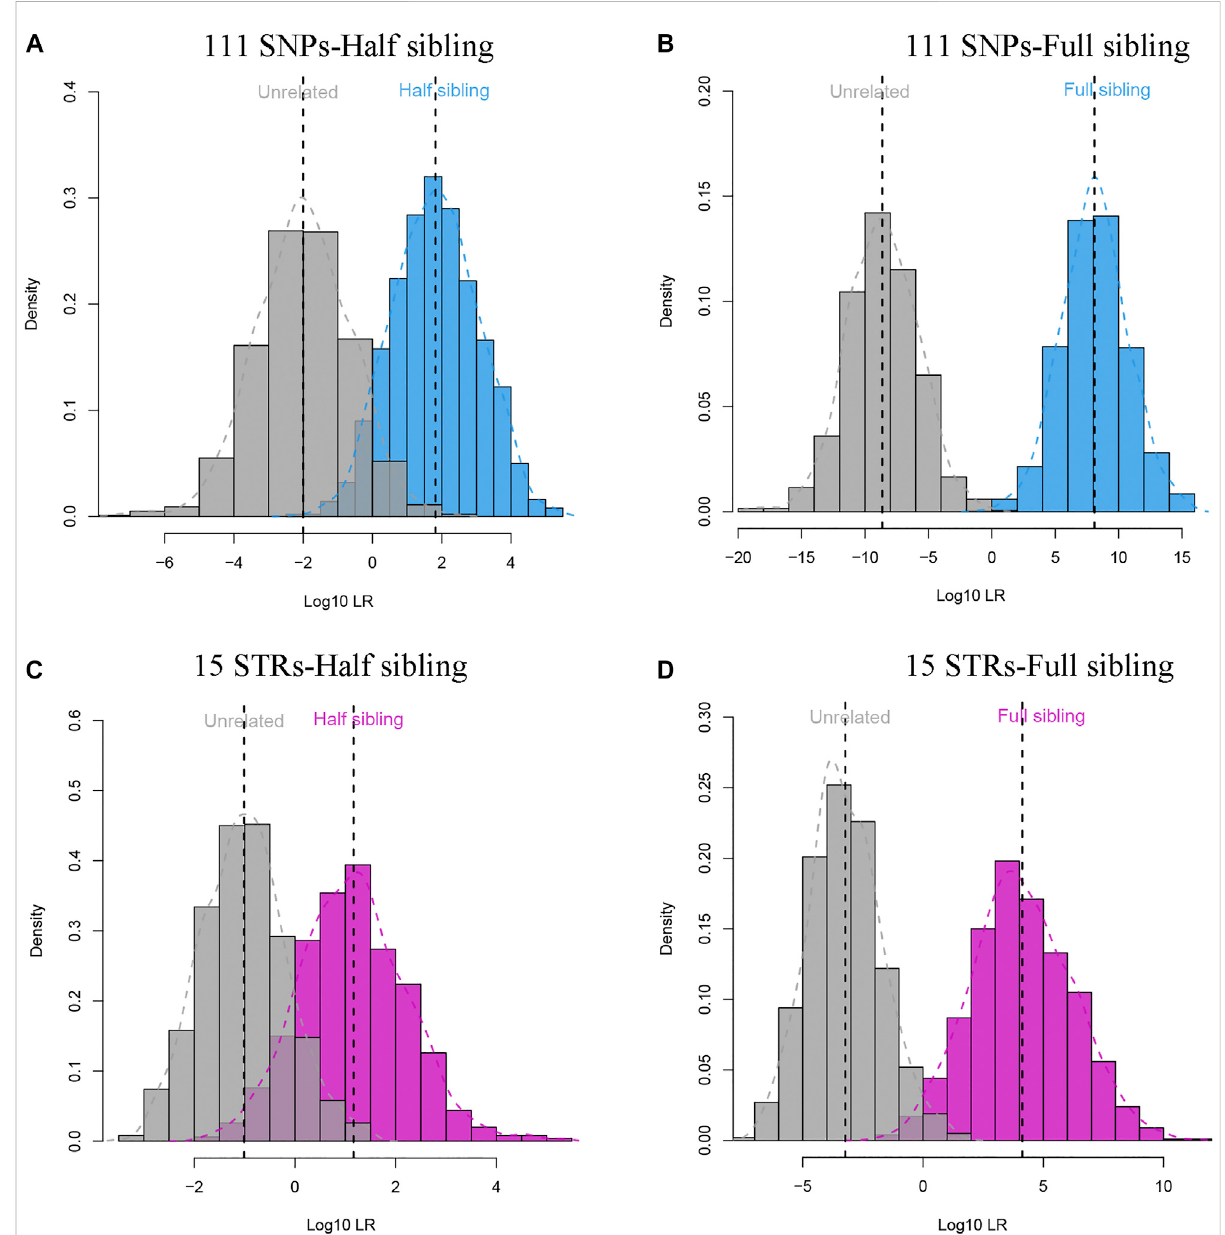
FIGURE 3 Log 10 LRdistribution plots of full sibling and half sibling tests based on 111 II-SNPs and 15 STRsin the Manchu group. (A) Log 10 LRdistributions to distinguish half siblings from unrelated individuals in the IMM group based on 111 II-SNPs; (B) Log 10 LR distributions to distinguish full siblings from unrelated individuals intheIMM group basedon the111II-SNPs; (C) Log 10 LRdistributions todistinguish half siblings from unrelated individuals inthe Manchu group based on 15 STRs; (D) Log 10 LR distributions to distinguish full siblings from unrelated individuals in the Manchu group based on 15